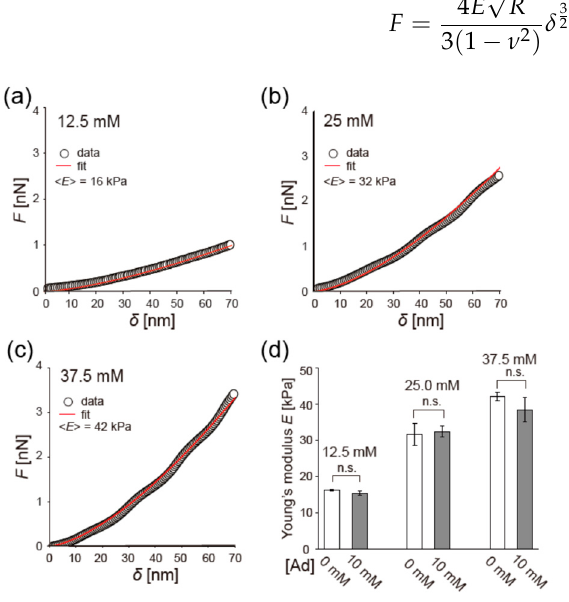
Figure 5. Characteristic force–distance curves of a single gelatin- β CD-Ad fiber crosslinked at different concentrations of EDC and NHS: ( a ) [EDC] = [NHS] =12.5 mM, ( b ) 25.0 mM, and ( c ) 37.5 mM. The best fit results obtained using the Hertz model for a spherical indenter is shown as solid lines, yielding the following Young’s moduli: E 12.5 = 16 kPa, E 25.0 = 32 kPa, and E 37.5 = 42 kPa. ( d ) Young’s